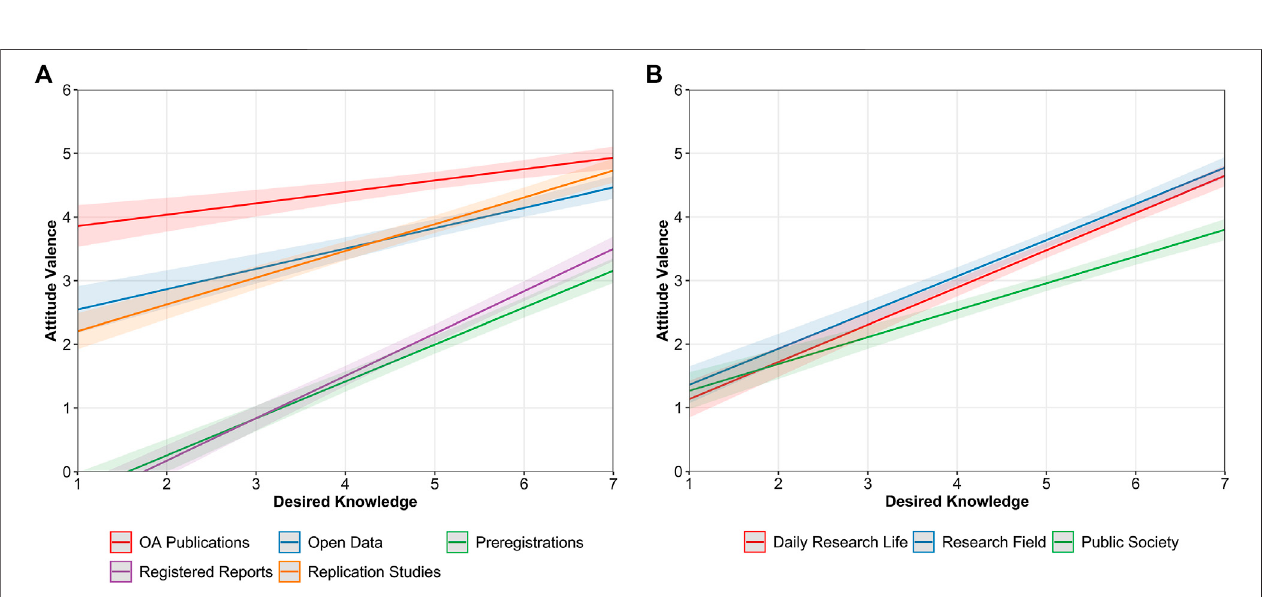
Frontiers in Research Metrics and Analytics |